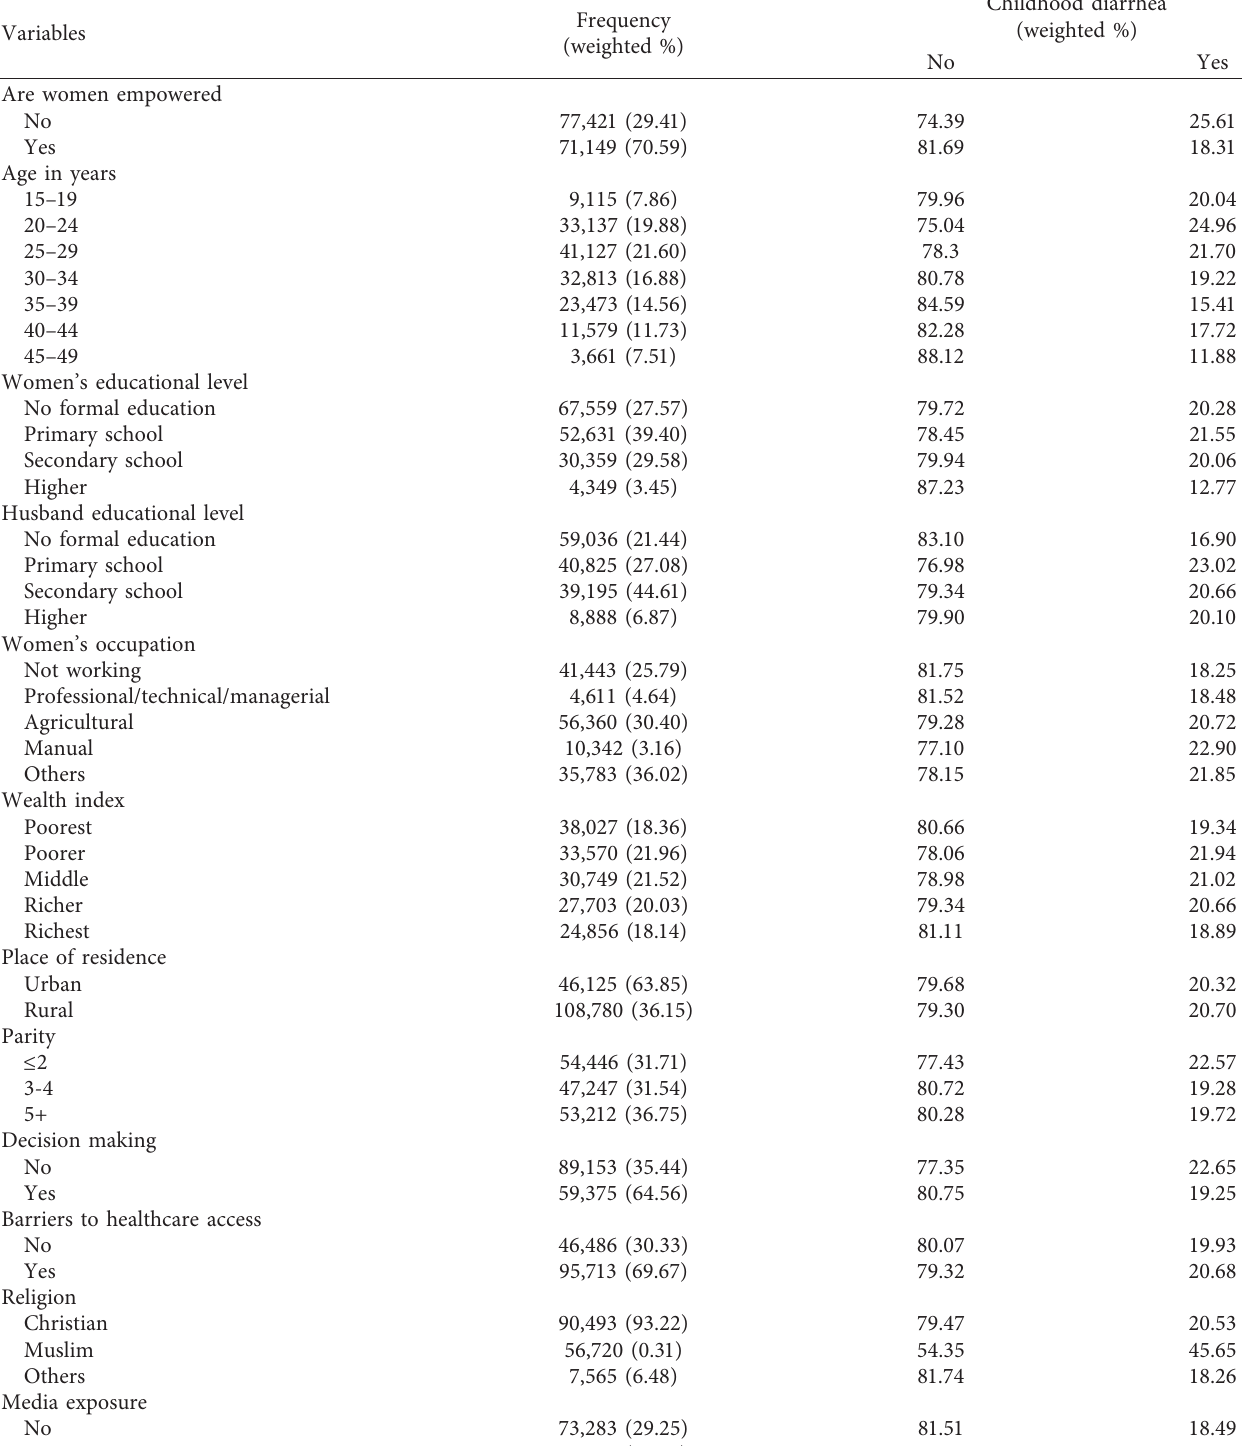
Table 2: Frequency distribution of respondents and distribution of childhood diarrhea cross explanatory variables: evidence from 25 SSA